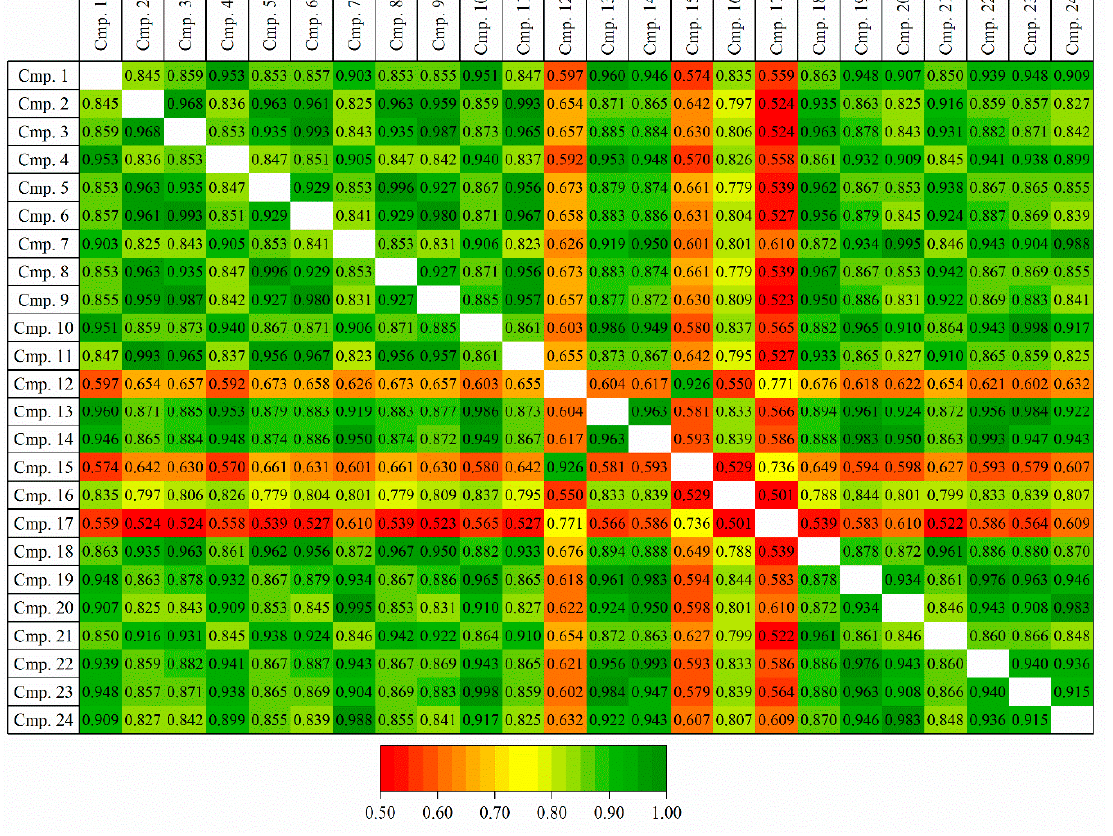
Figure 1. Pairwise structural similarities expressed as Tanimoto index. See text for details.